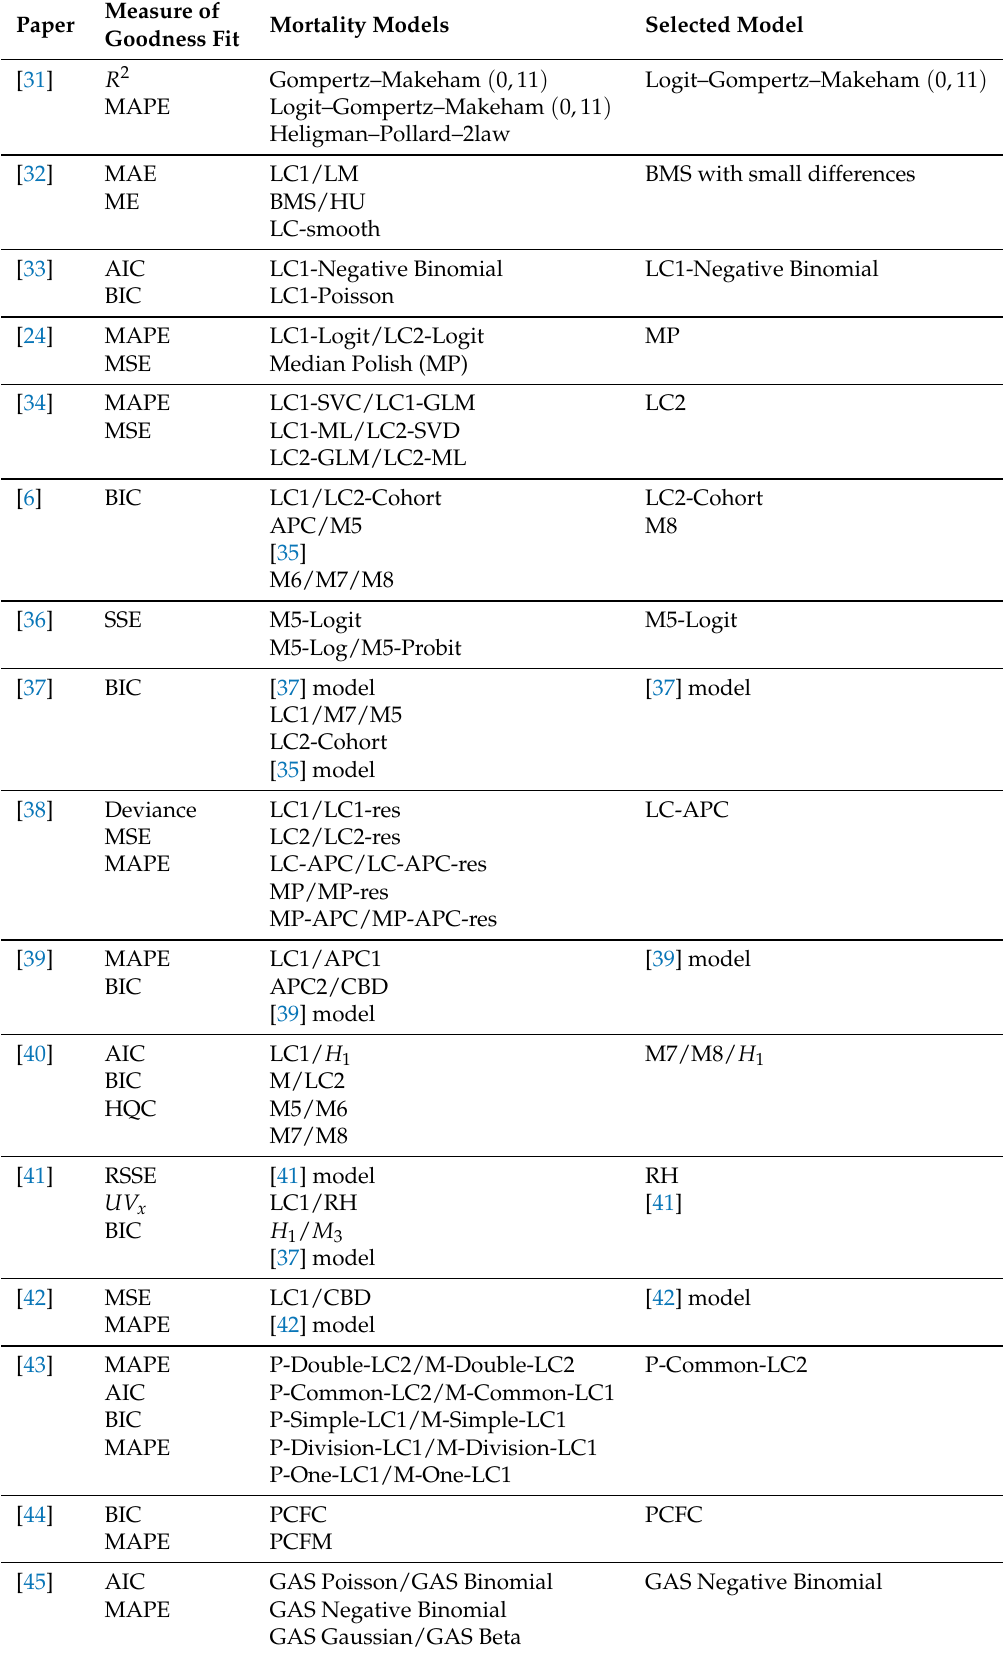
Table 1. Summary of goodness-of-fit